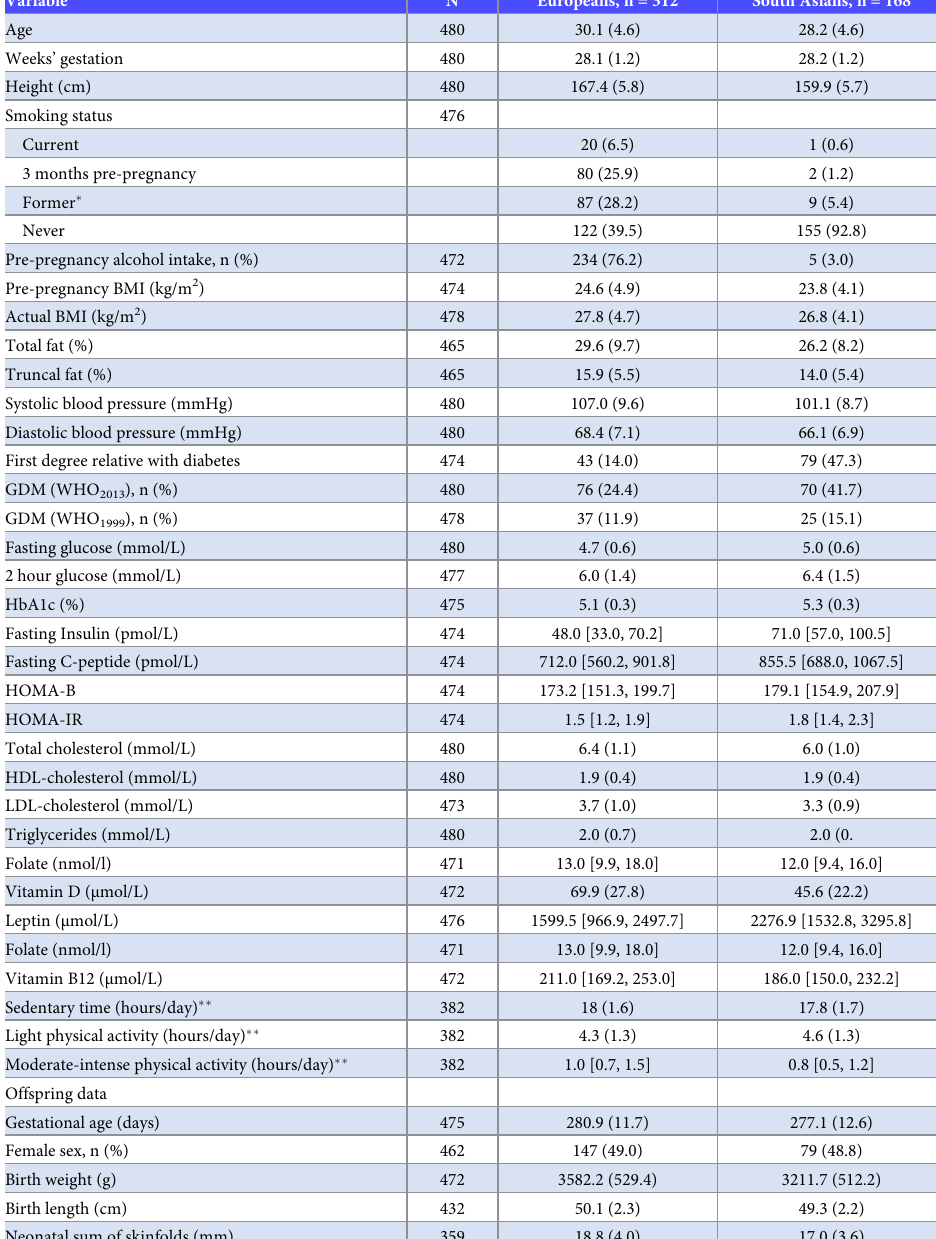
Table 1. Characteristics of the EPIPREG